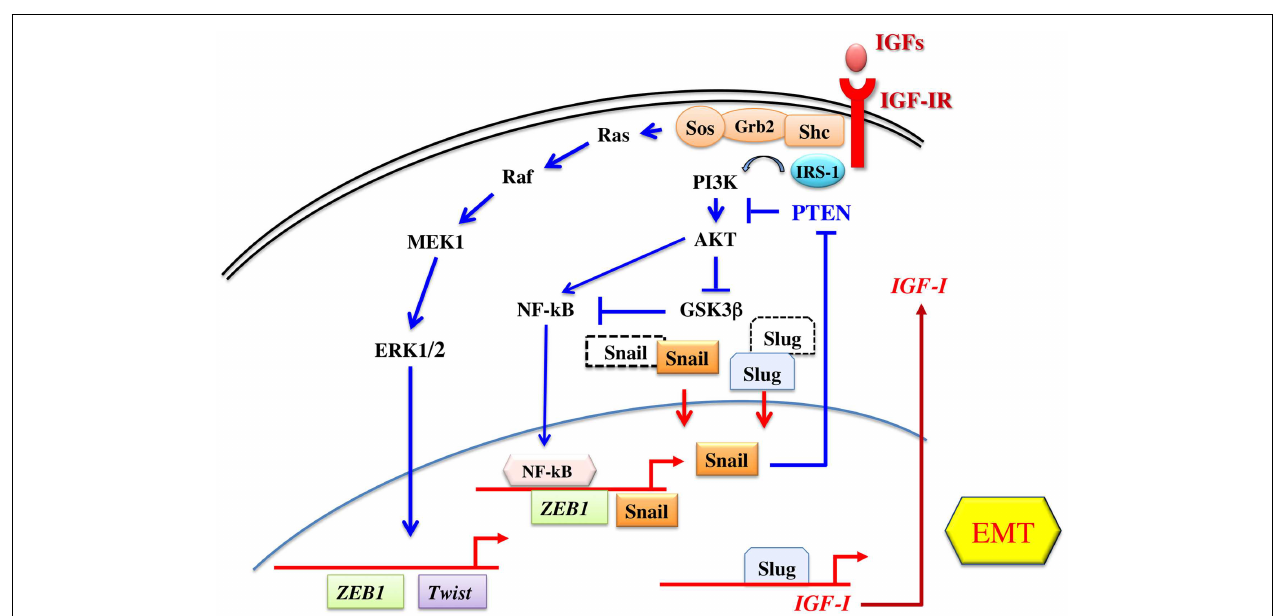
pathway also induces the activation of NF-kB transcription factor, which then increases the transcription of Snail and ZEB1. On the other hand, the Ras/Raf/ERK pathway is involved in the transcription ofTwist and ZEB1. In turn, Snail inhibits PTEN gene transcription, thus potentiating the IRS-1/PI3K/Akt pathway. In addition, Slug increases the transcription of IGF-I, the main IGF-IR